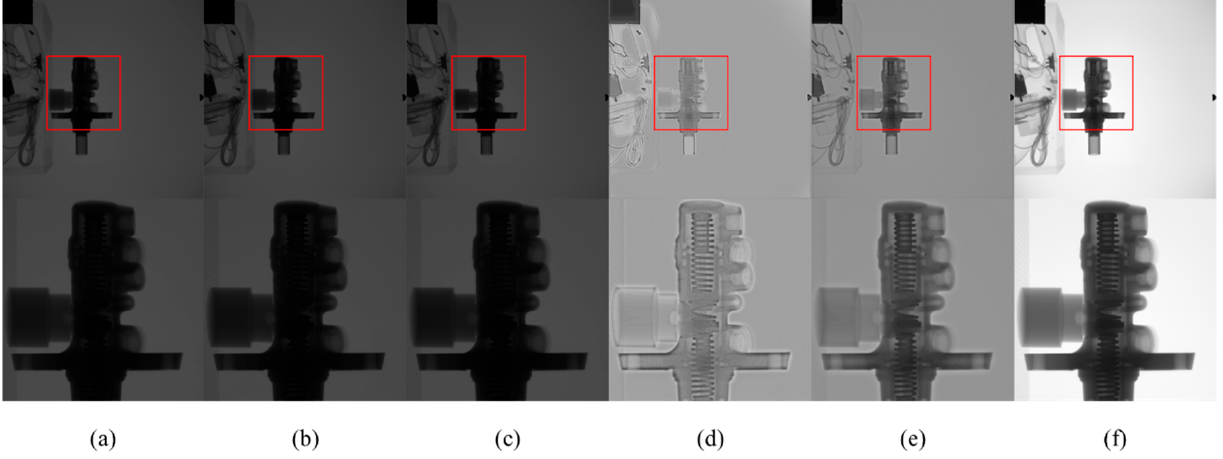
Figure 13. The contrast enhancement results of different methods. Top: raw image and the enhance- ment results; bottom: zoomed-in views on the highlighted area. ( a ) The raw images; ( b ) CLAHE; ( c ) LCM-CLAHE; ( d ) Retinex-Net; ( e ) Zero-DCE; and ( f ) our